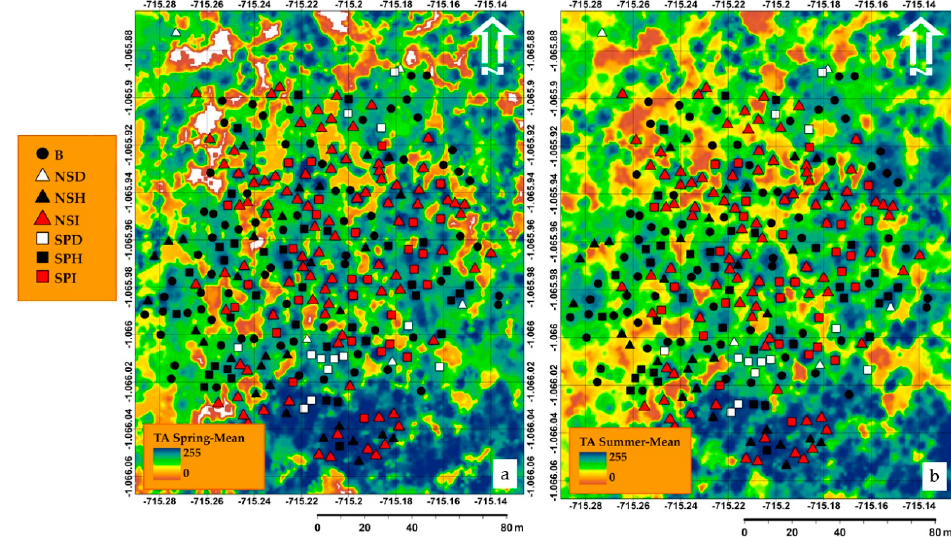
Figure 10. Mean texture measure parameter applied in the normalized canopy height model (nCHM) ( a ) in spring and ( b ) in summer, including the locations of healthy, infested, and dead trees based on their species classes (B = Broadleaves, NSD = Norway spruce dead, NSH = Norway spruce healthy, NSI = Norway spruce infested, SPD = Scots pine dead, SPH = Scots pine healthy, SPI = Scots pine